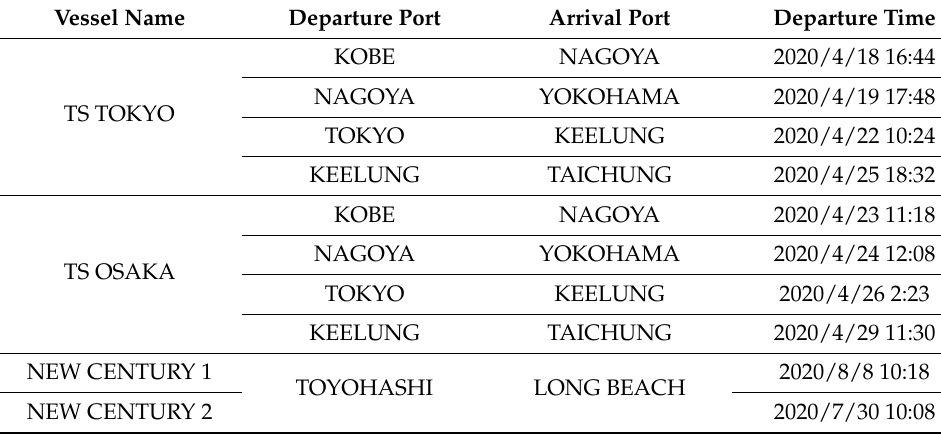
Table 1. Target vessels used to verify the prediction